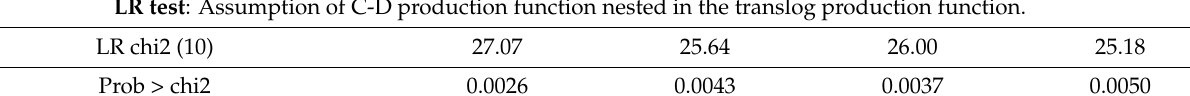
Head of household characteristics